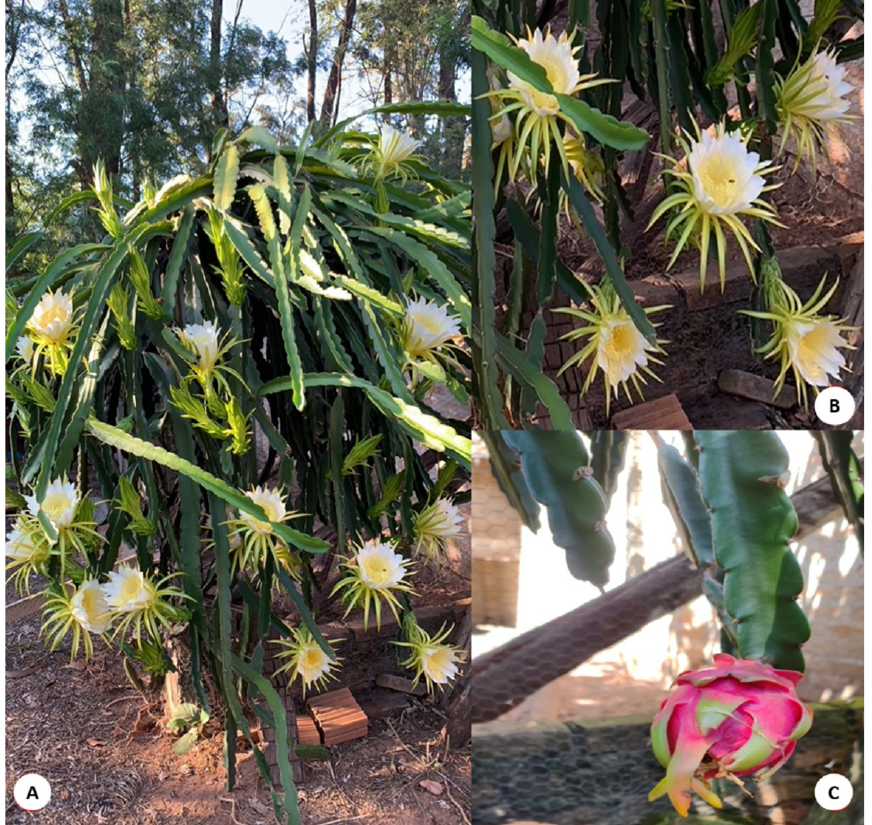
Figure 1. ( A ) pitaya plant, ( B ) flower, ( C ) fruit of H. undatus.